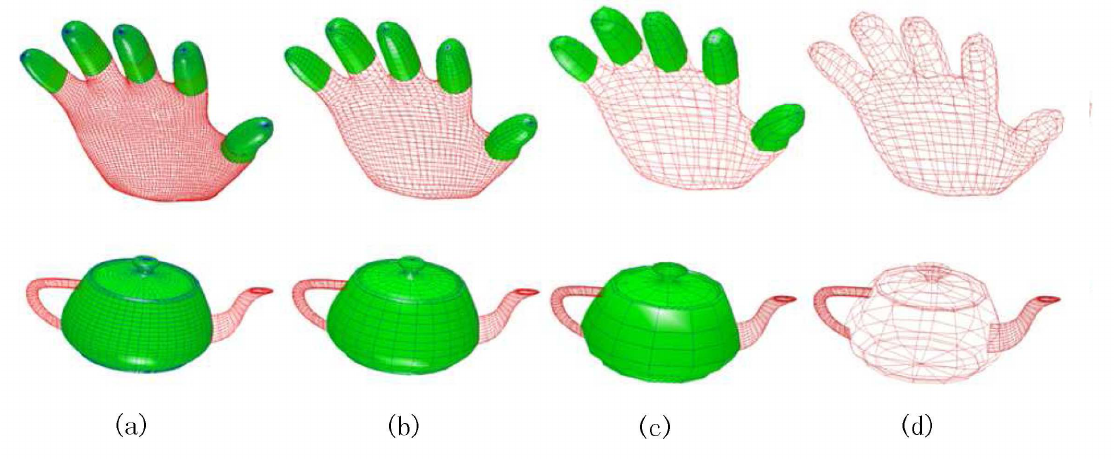
Figure 1. Surface sequences in different resolution: (a) original surfaces, (b) and (c) surfaces by compound subdivision wavelet analysis once and twice; (d) meshes in lowest